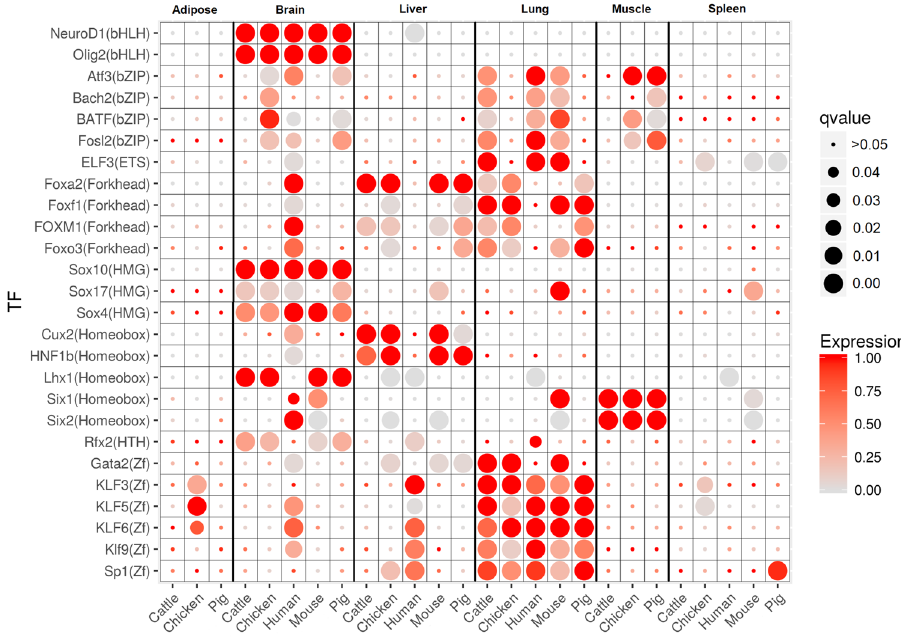
Fig. 3 Transcription factor motifs enriched in tissue-speci fi c footprints show similar patterns across species. Transcription factor motifs enriched in at least one tissue in all three domestic animal species. The size of the circle indicates the statistical signi fi cance of motif enrichment (Benjamini – Hochberg adjusted p -values using HOMER), while the color indicates the expression of the corresponding transcription factor gene, normalized to the maximum expression across tissues within each